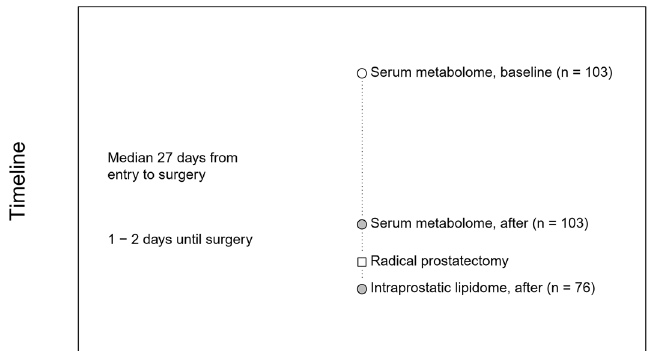
Figure 1. Schematic representation of the serum lipid and lipoprotein lipid and intraprostatic tissue lipidome measurement time-points. The serum lipid and lipoprotein lipid content was obtained at two different time- points, whereas the intraprostatic lipidome is obtained only once after the